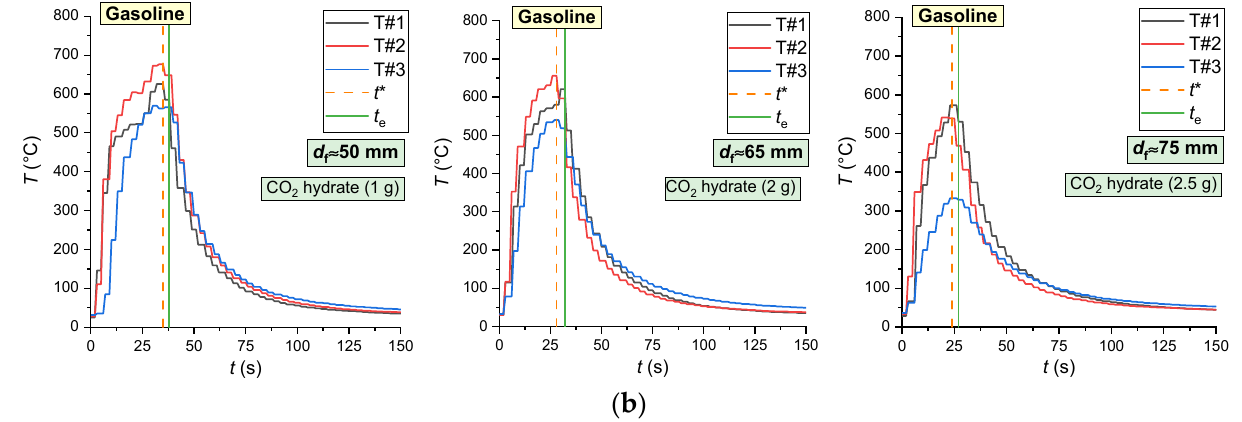
Figure 13. Flame temperature variation dynamics for laboratory-scale pool fires of different diameters ( d f = 50–75 mm) consisting of gasoline ( V 0 ≈ 3 mL) and burning without extinguishing ( a ) and when exposed to CO 2 hydrate powder ( b ).